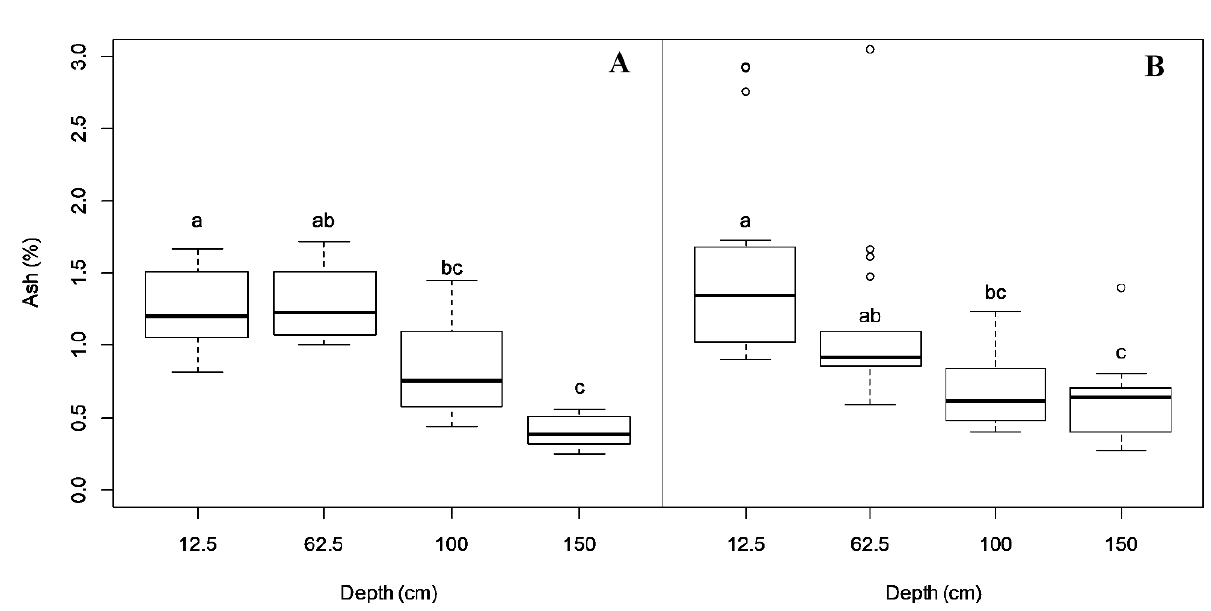
Figure 4. Variation in ash content (%) at (a) Forest and (b) Open areas at four selected sampling depths (12.5 cm, 62.5 cm, 100 cm and 150 cm). Ash content values (%) were arcsine-transformed prior to ANOVA, conducted at α = 0.05. Superscripts with different letters (a, b, c) within a panel indicate significant differences. Thick black line in boxplot represents median value. Hollow circles represent